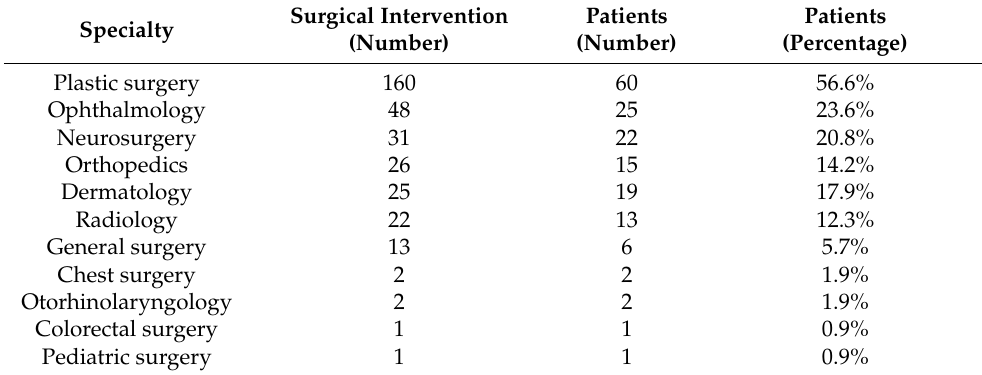
Table 2. Specialties involved in surgical care of patients ( n = 106) with neurofibromatosis type